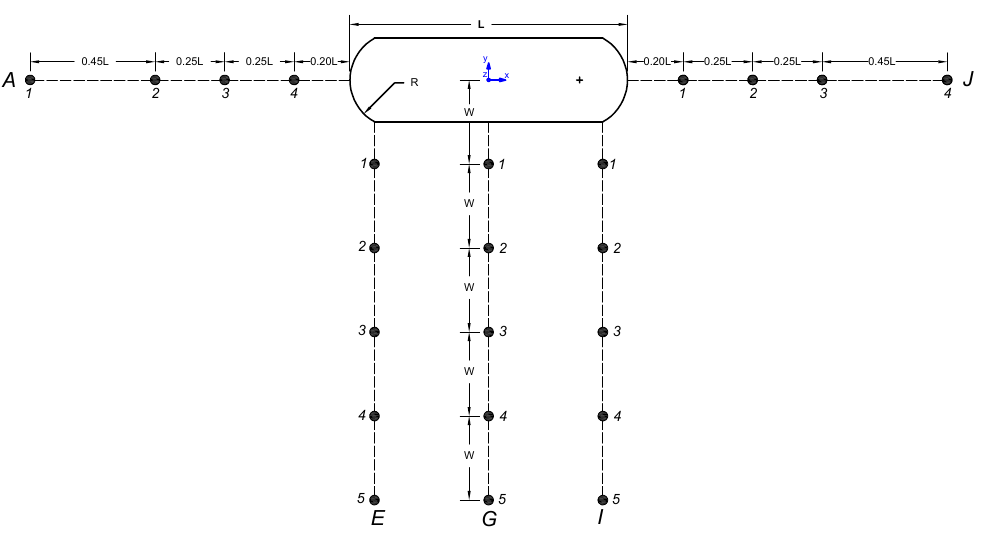
Figure 5. Schematic diagram of the velocity point measurements. Profiles on the longitudinal half- planes ( A and J ) are numbered from left to right, while those on the transversal half-planes ( E , G , and I ) are numbered from the pier outwards.